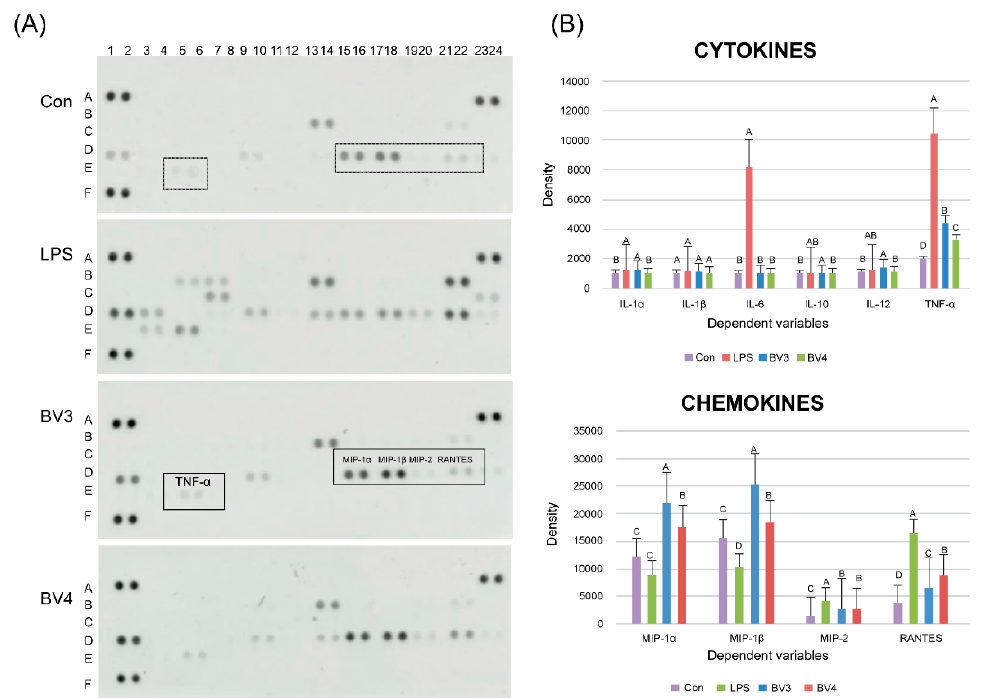
Figure 4. Effect of BV samples on the production of immune-enhancing cytokines and chemokines in RAW 264.7 macrophages. ( A ) Cytokine and chemokine array. ( B ) Densities of cytokines and chemokines by image analysis. Con, control without BV samples and LPS; BV3, with unpeeled roots and a starter culture; BV4, with peeled roots and a starter culture.